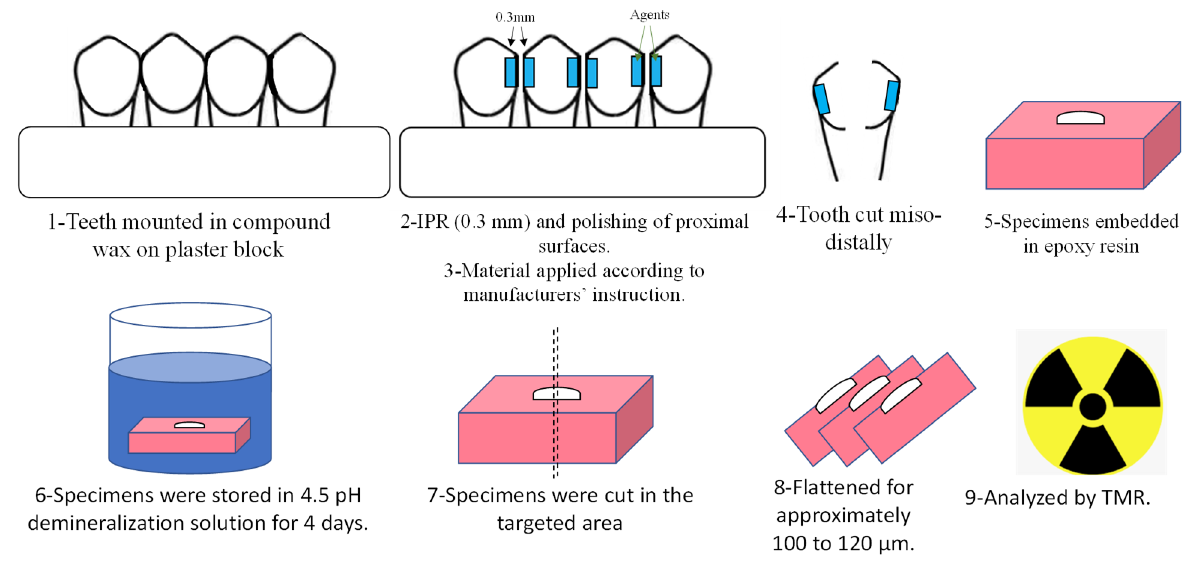
Figure 1. Summary of the experimental procedures.